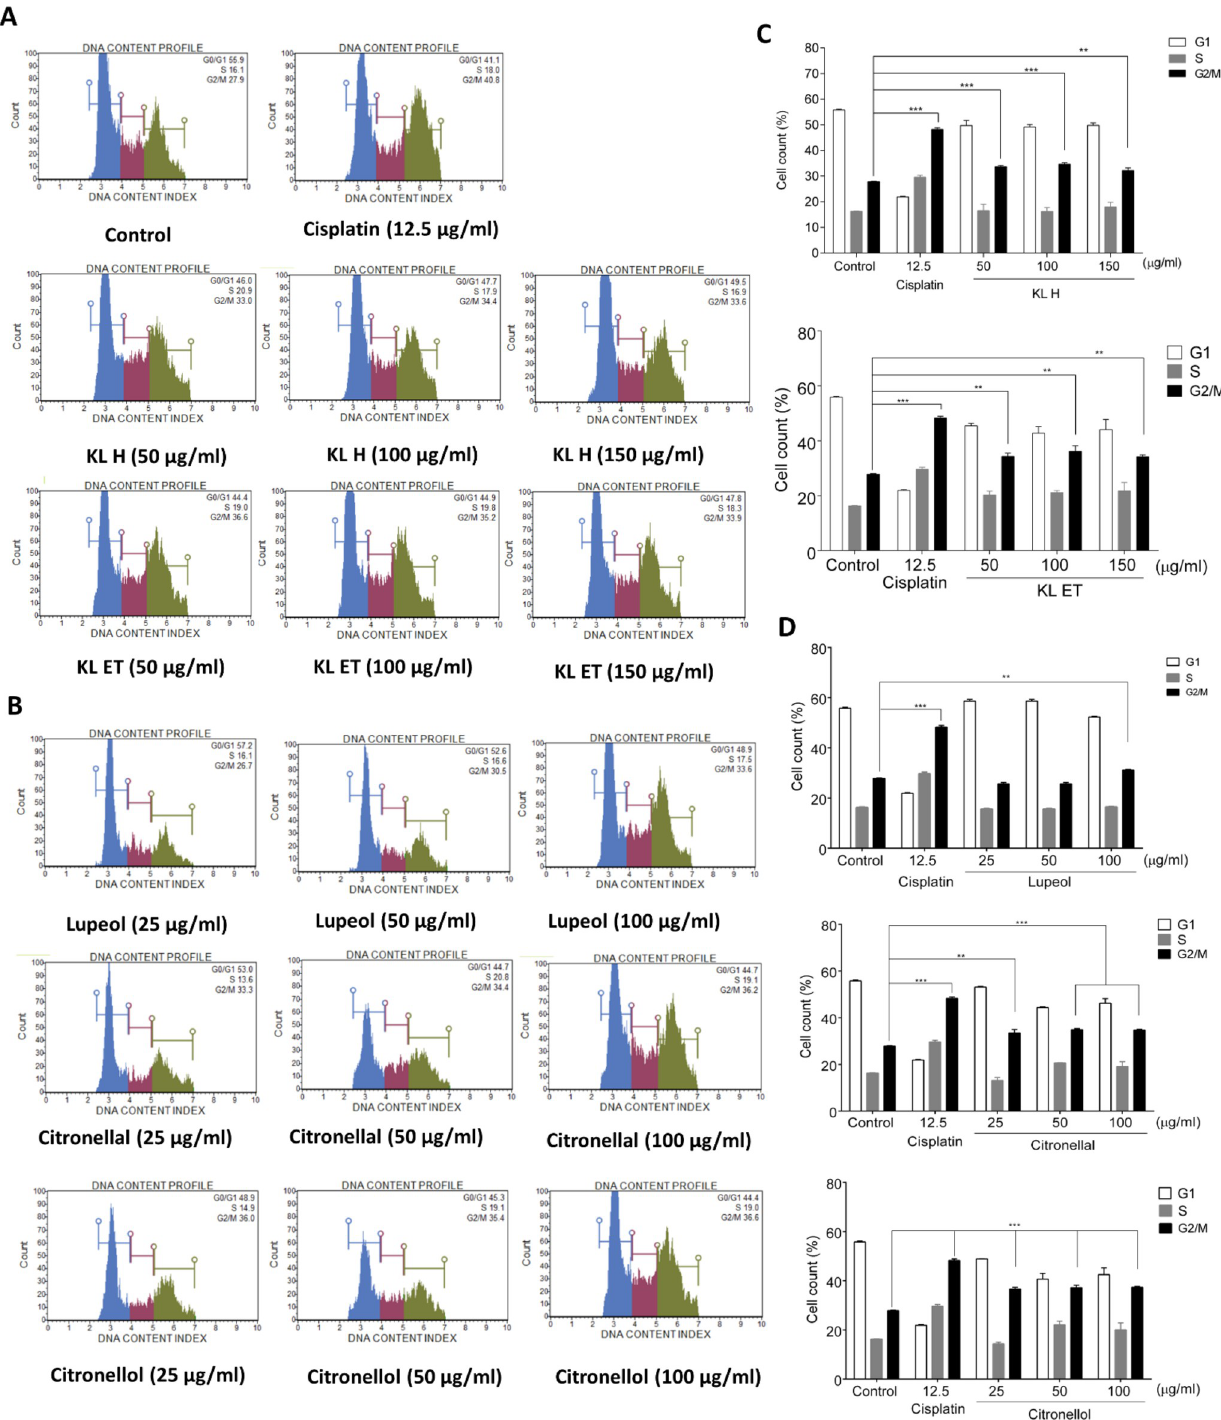
Fig 2. Efficacy of KL H, KL ET, lupeol, citronellal and citronellol on the distribution of SCC15 in the cell cycle analyzed by a Muse ™ Cell Analyzer. (A), and (B) DNA content index histograms of cell populations in each phase of the cell cycle in SCC15 cell line after treatment with cisplatin, crude extracts and compounds for 24 hours. (C) and (D) show the percentage of cells in G1, S and G2/M phase for the SCC15 cell line. Data are presented as means ± SEM. �� Statistically significant ( p � 0.01) and ��� p � 0.001 compared to the control. KL H: Crude hexane; KL ET: Crude ethanolic extract.